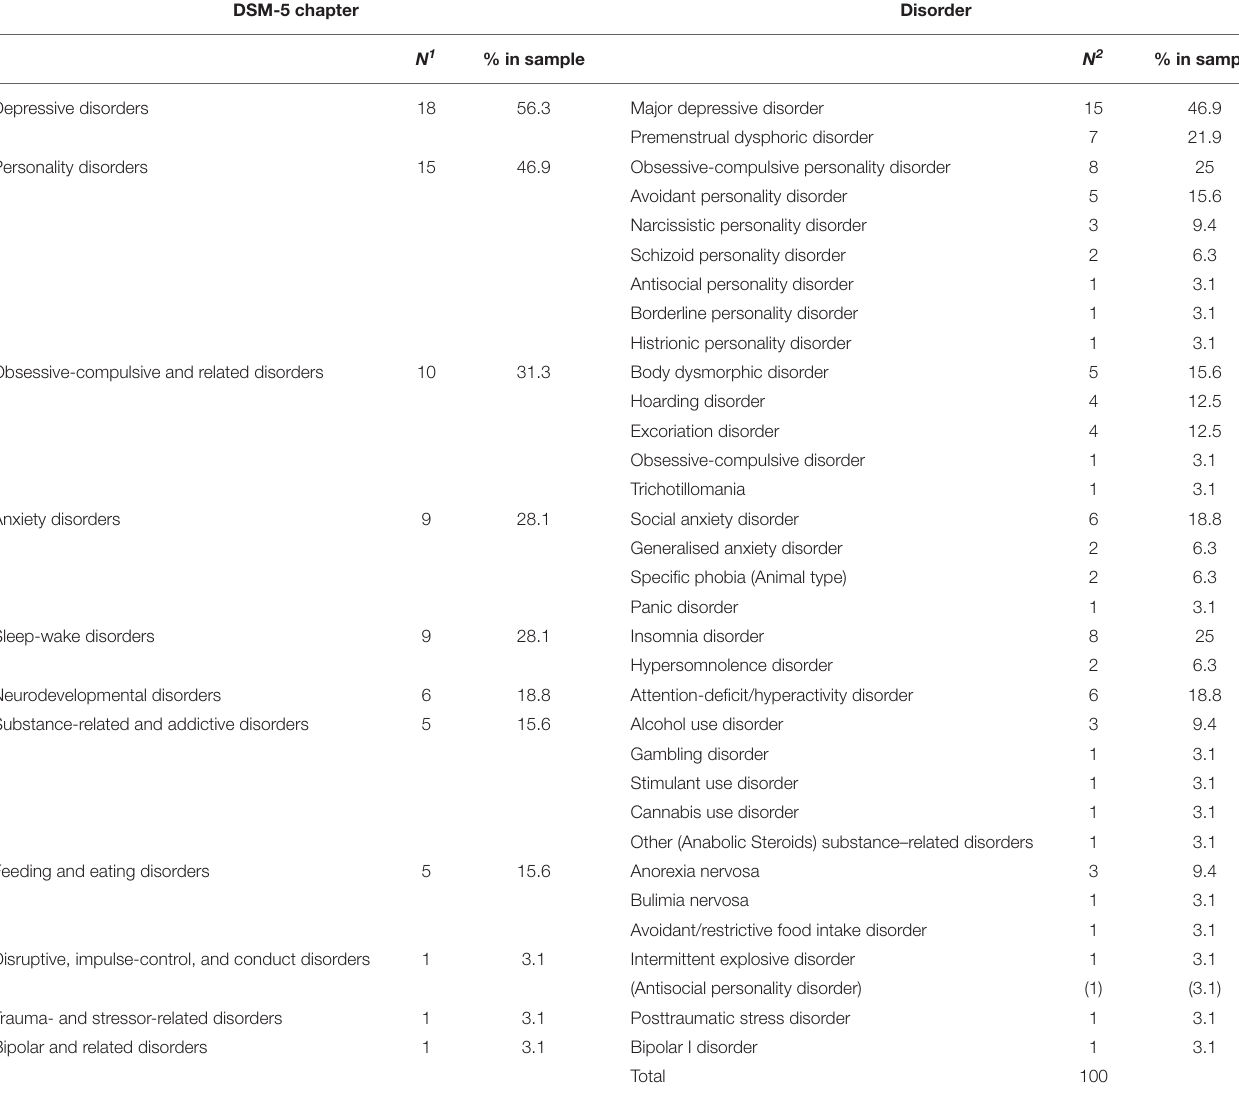
TABLE 2 | DSM-5 chapters and their according disorders currently prevalent in our sample ( n =